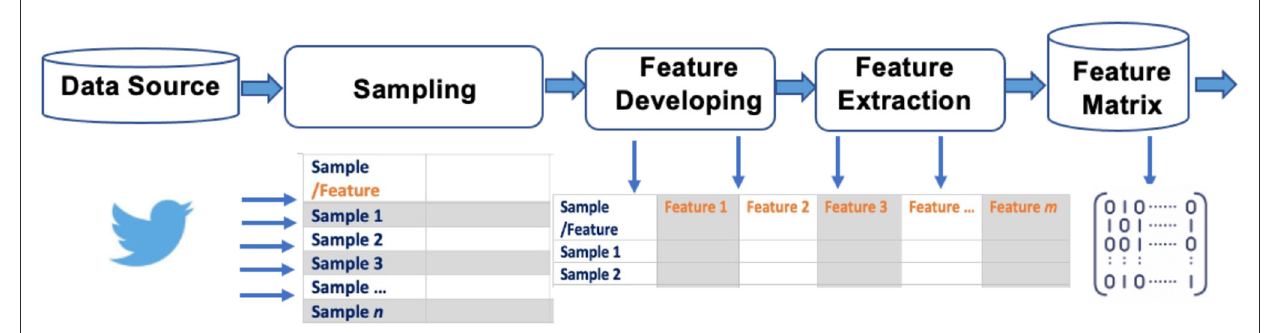
of information to be extracted from each post: (1) time, (2) location, (3) content, and (4)